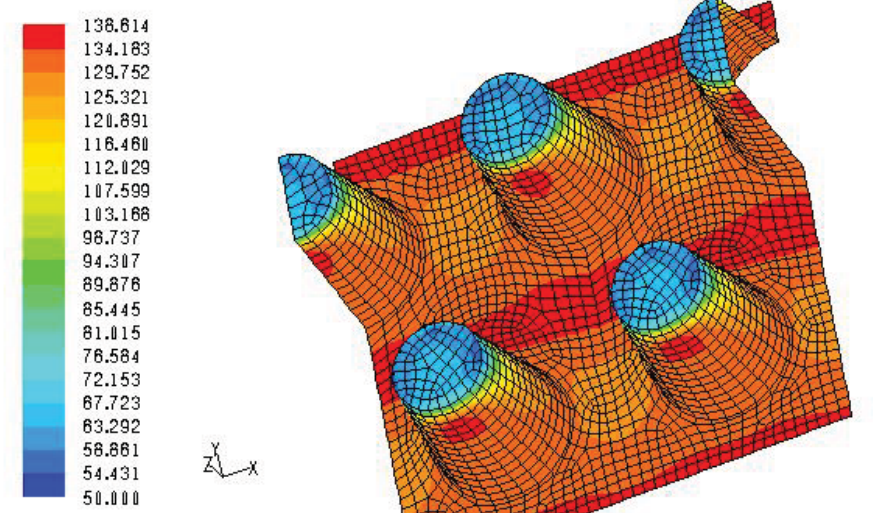
Figure 5: Typical pattern of contact protrusions - mesh, coloured by the dynamic pressure